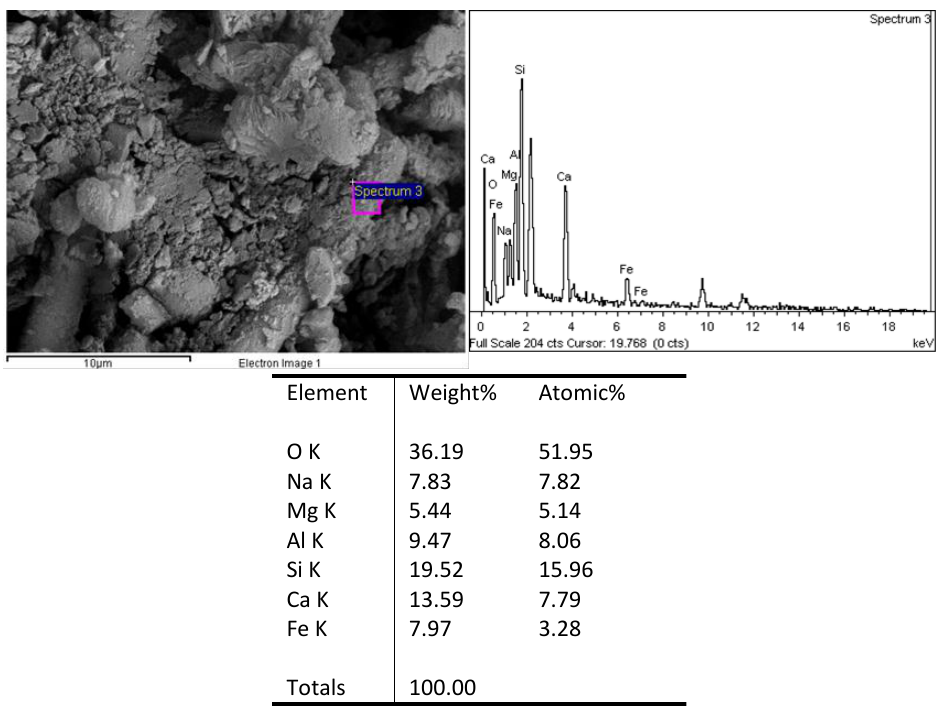
Figure 15. EDS spectrum alkali-activated cement